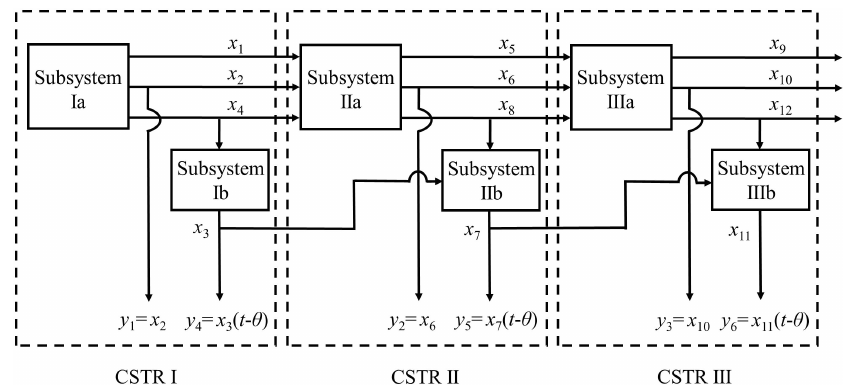
Figure 4. Subsystems representation of three CSTRs in series.